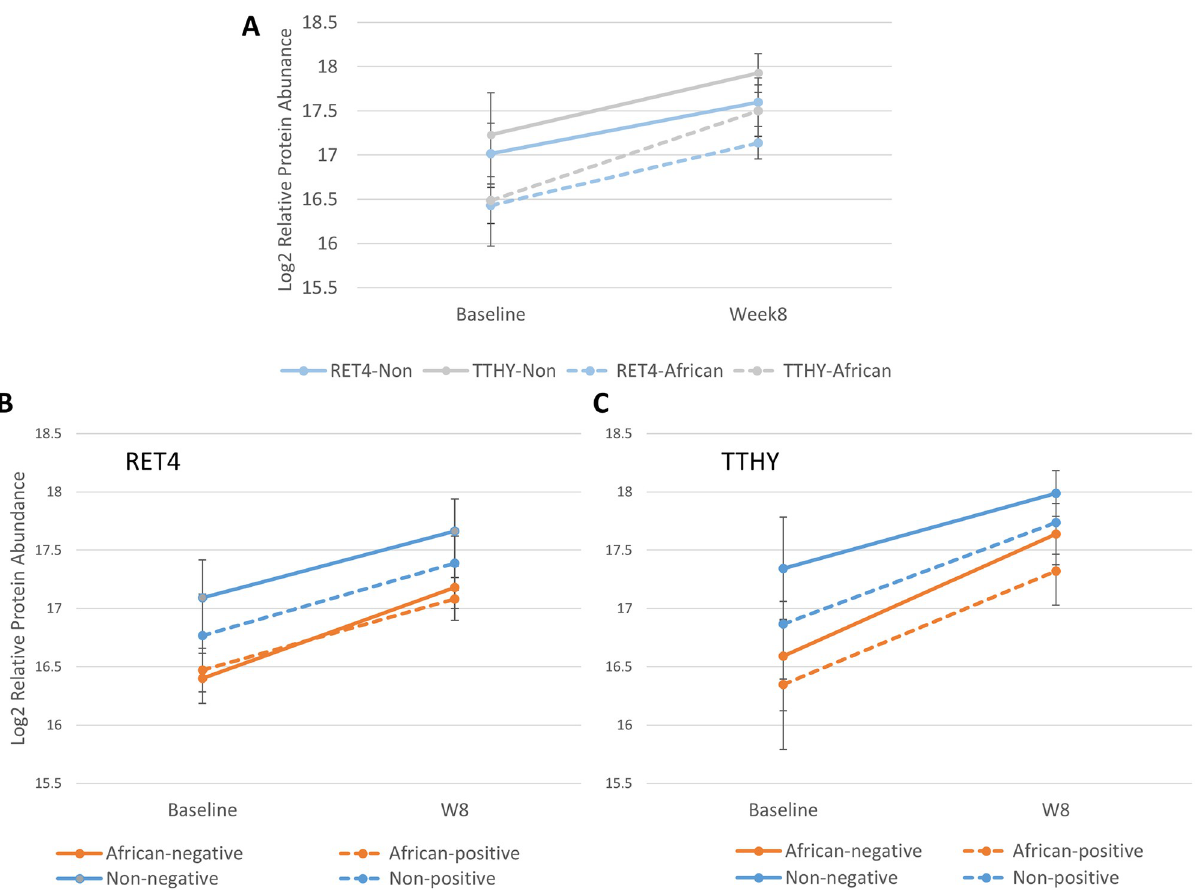
Fig 6. Comparing retinol binding protein and transthyretin abundances to understand inflammation and vitamin A deficiency in African TB patients. A) graph combining Retinal Binding Protein (RET4/RBP) and Transthyretin (TTHY) abundance changes between cohorts. B) Graph of RET4 only, stratified across both cohorts and patient culture status (positive encompasses both liquid and solid) at 8 weeks as a measure of outcome. C) Graph of TTHY only, stratified across both cohorts and patient culture status. Error bars for all panels represents the variance across patient population for each protein and time